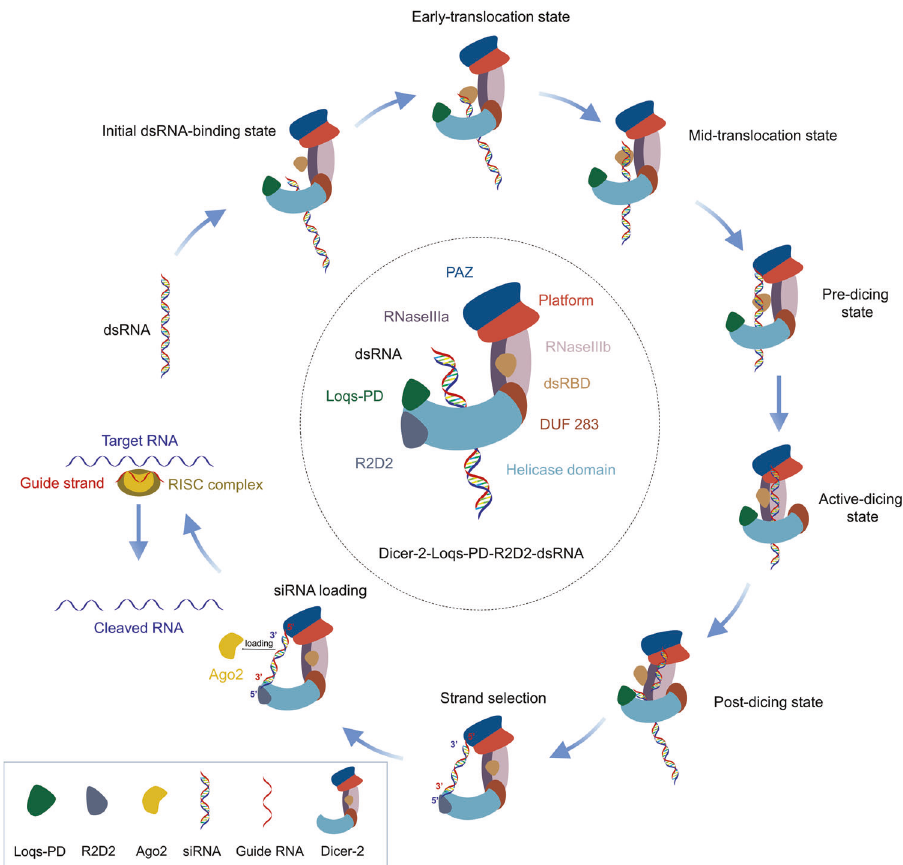
Fig. 1 Schematic diagram demonstrating the full cycle of Dicer-2 complexes in dsRNA processing. Starting from the recognition of dsRNA on the left, the step by step of dsRNA processing by Dicer in a clockwise direction. In the middle is a detailed view of the Dicer-2-Loqs-PD-R2D2- dsRNA